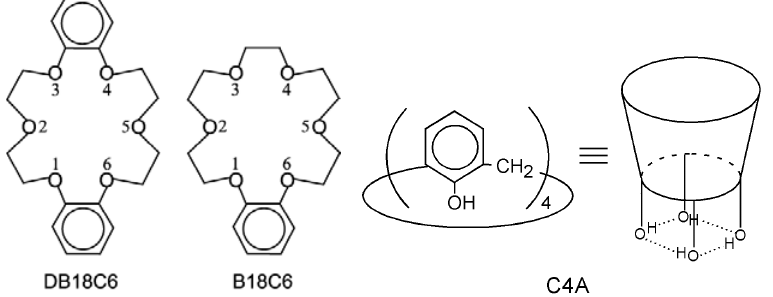
Figure 1. Schematic structures of dibenzo-18-crown-6-ether (DB18C6), benzo-18-crown- 6-ether (B18C6), and calix[4]arene